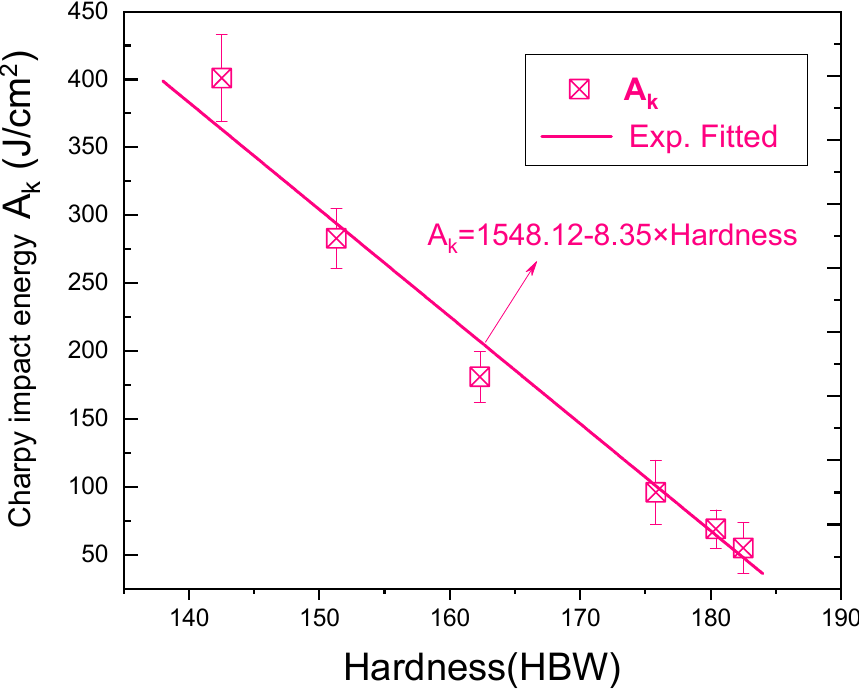
Figure 7. Relationship between Charpy impact energy and Brinell hardness value after aging at 750 750 ◦ °C .